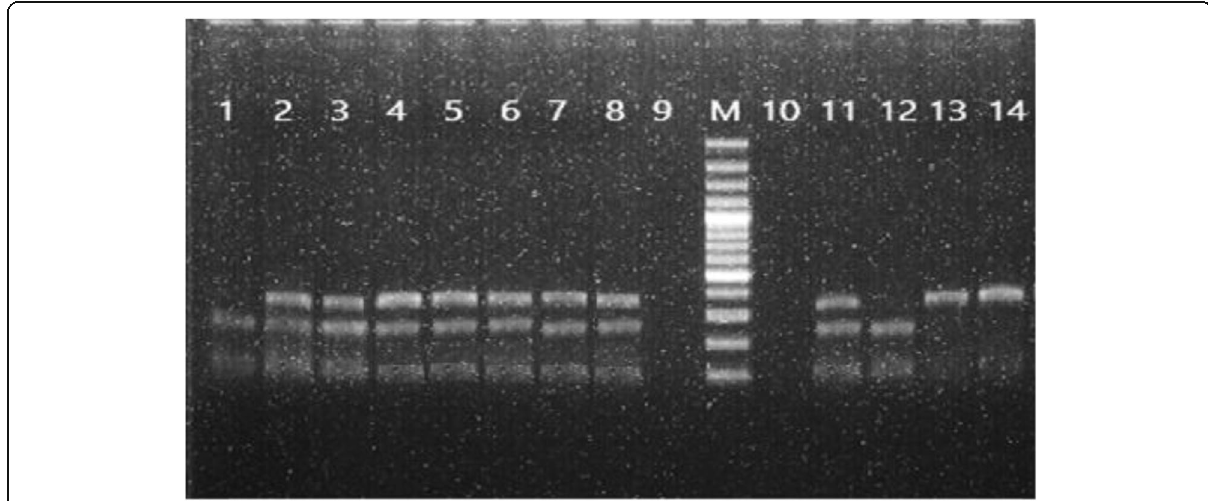
Fig. 2 Genotypes of the C/G polymorphism at the − 888-bp SDH promoter region determined by the PCR-based BseDI restriction fragment length polymorphism (RFLP-PCR) and analyzed by 2% agarose gel electrophoresis, stained with ethidium bromide, and viewed by gel documentation system. Lanes 1 and 12 show the result of amplification of G/G homozygote; lanes 13 and 14 show homozygote C/C; lanes 2, 3, 4, 5, 6, 7, 8, and 11 show heterozygote G/C; lanes 9 and 10 are empty; lane M is (100 bp) the DNA